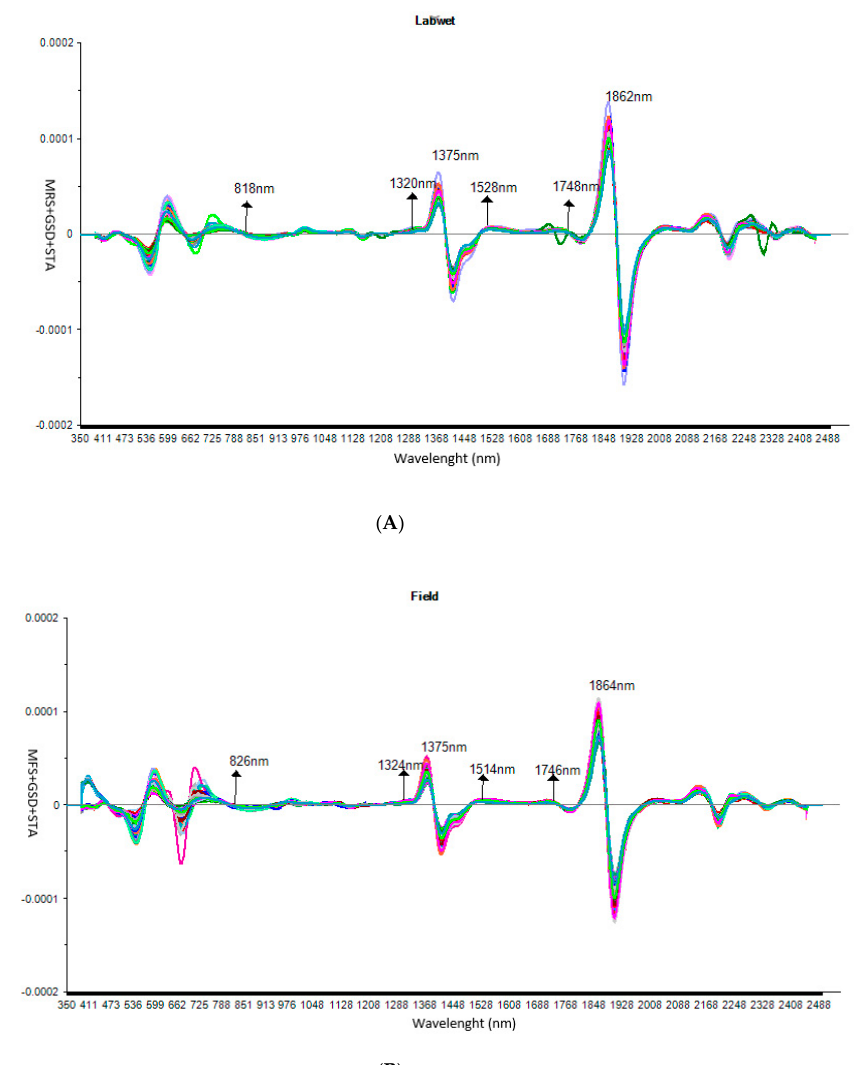
Figure 4. Spectral response after median filter smoothing (MFS) + spectroscopic transformation-absorbance (STA) + gap-segment second derivative (GSD) transformation for lab-wet ( A ) and field ( B ) spectra datasets (highlighting their various spectra features).